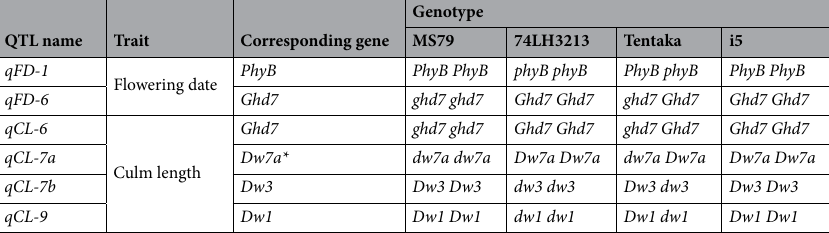
Table 2. Summary of the detected QTLs for flowering date and culm length and the candidate corresponding genes. *Identified in this